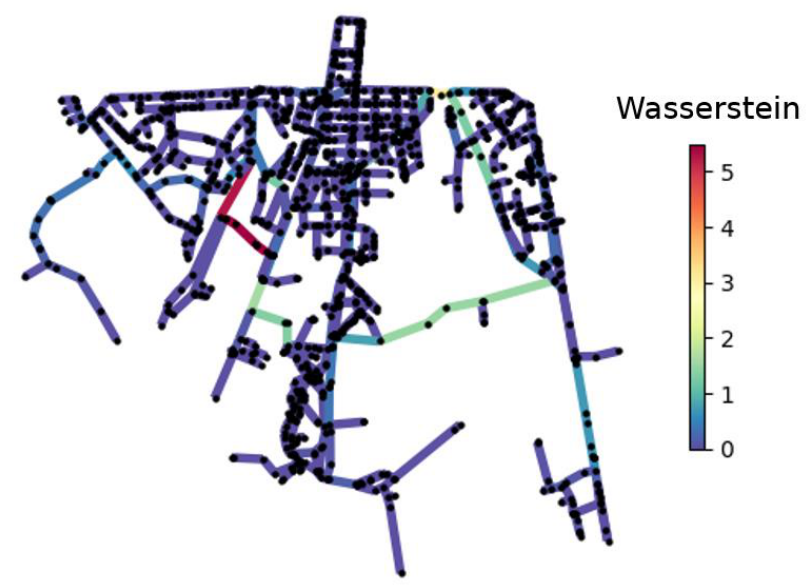
Figure 5. Heatmap of the Wasserstein distance for all edges in Abbiategrasso.